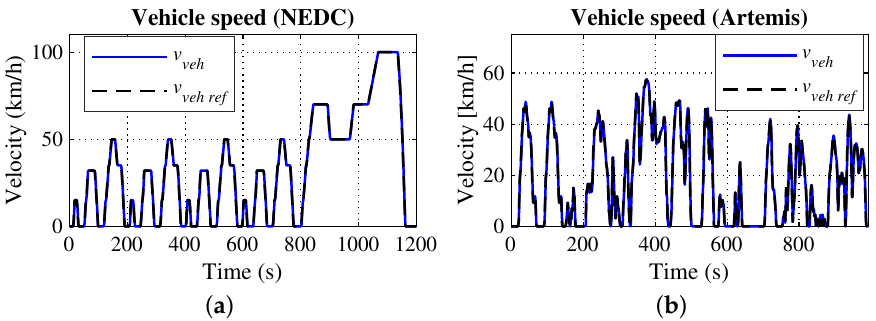
Figure 10. Velocity of the studied driving cycles: ( a ) NEDC; ( b ) Artemis urban.